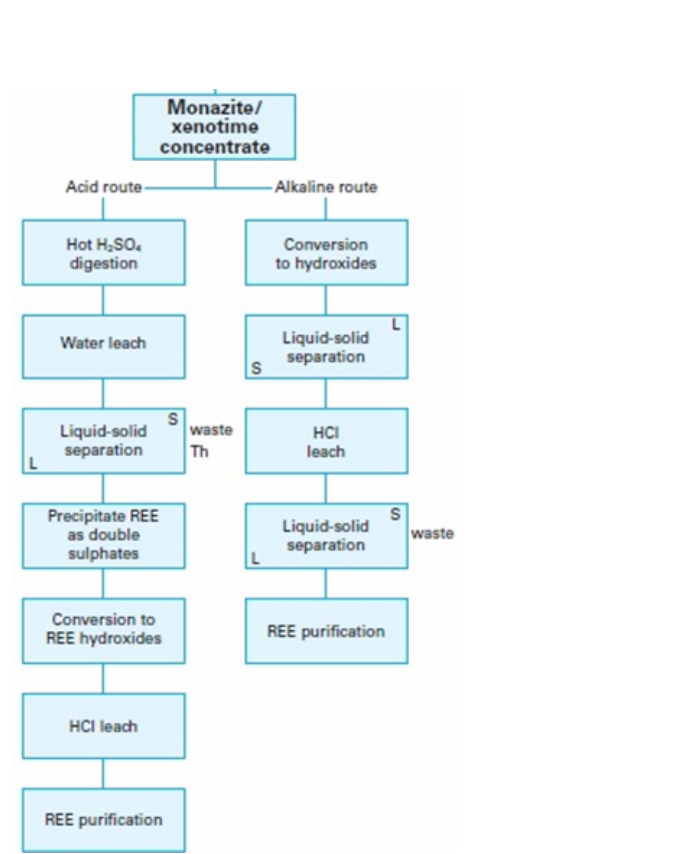
Figure 1 – Flow diagram of the dissolution of monazite and xenotime Рис . 1 – Диаграмма процесса растворения моноцита и